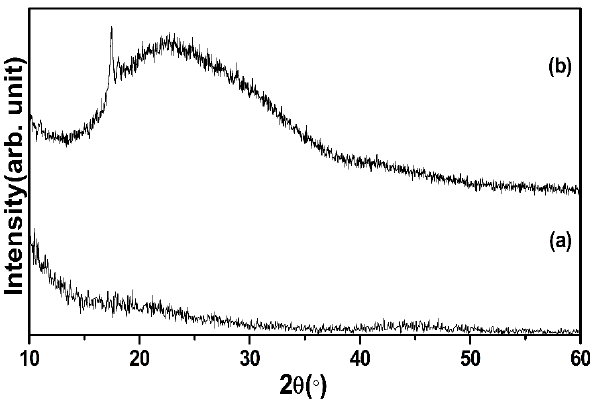
Figure 2. XRD spectra of pure ( a ) PU and ( b ) POSS-grafted PU nanomatrix.